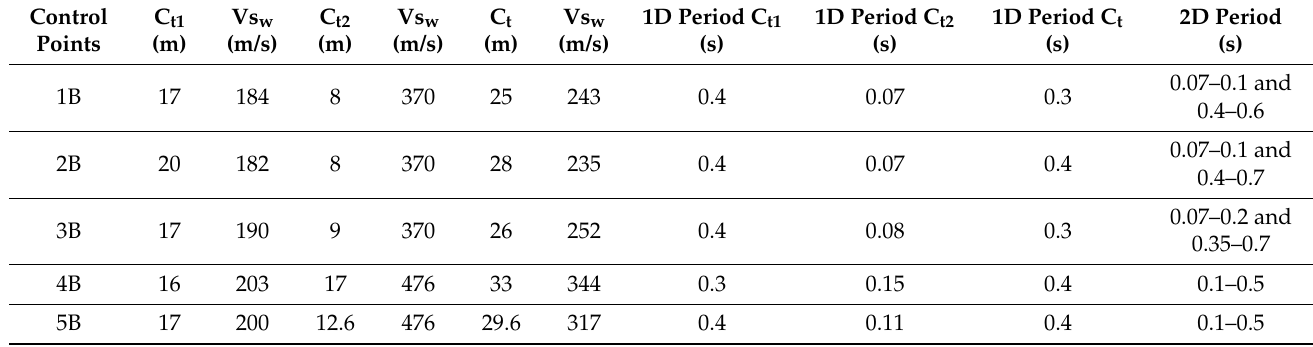
Table 8. Amplified periods calculated at 5 numerical control points along the sections BB (cid:48)